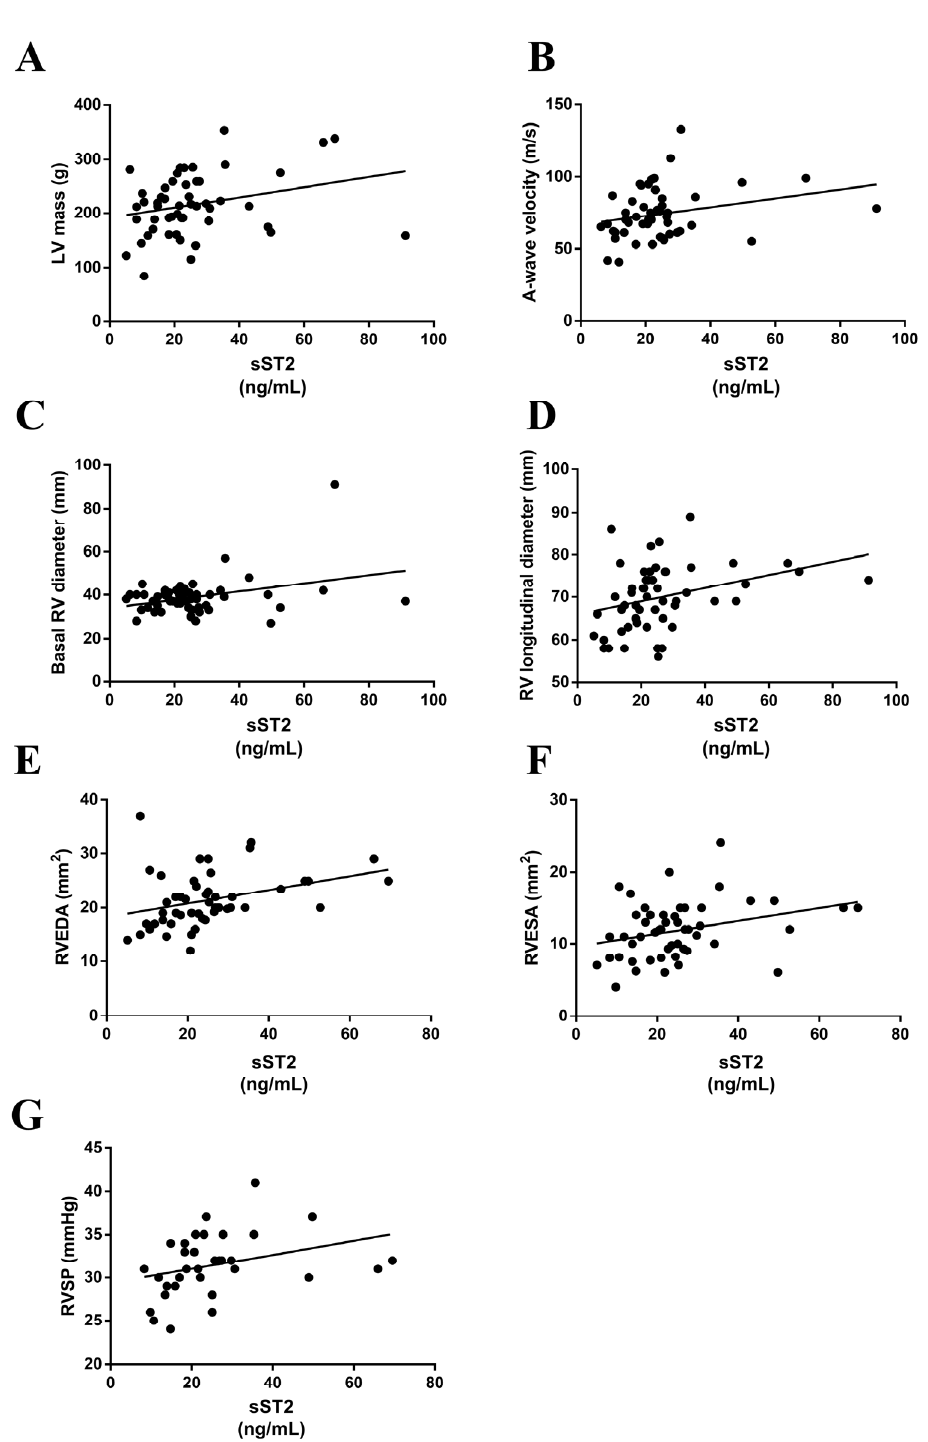
Figure 3. sST2 correlated with echocardiographic parameters. Serum levels of sST2 positively correlated with LVM ( A ), A-wave velocity ( B ), basal RV diameter ( C ), RV longitudinal diameter ( D ), RVEDA ( E ), RVESA ( F ) and RVSP ( G ). LVM, left ventricular mass; RV, right ventricular; RVEDA, right ventricular end-diastolic area; RVESA, right ventricular end-systolic area; RVSP, right ventricular systolic pressure.